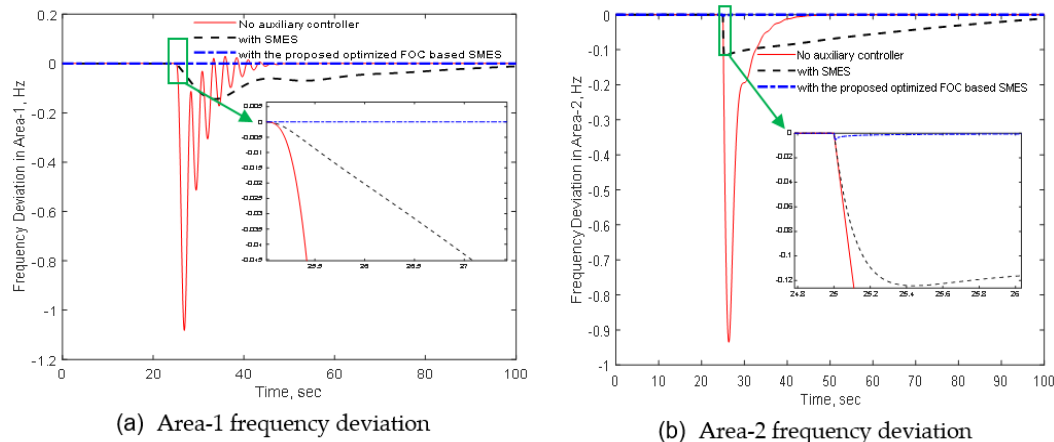
Figure 11. Frequency response for 0.3 p.u. load change in area-2.